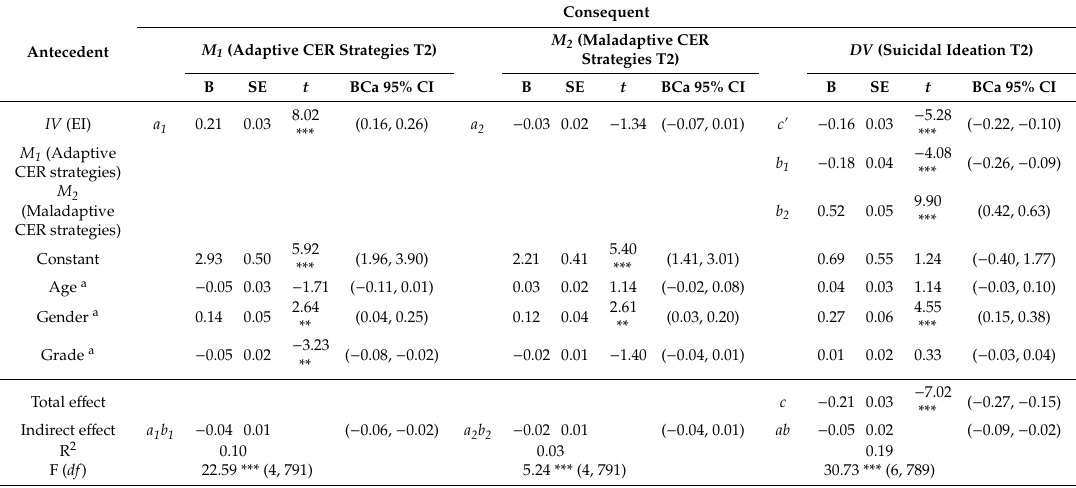
Table 4. Summary of the indirect e ff ects between EI (T1) and suicidal ideation (T2) through CER strategies (T2) (Study